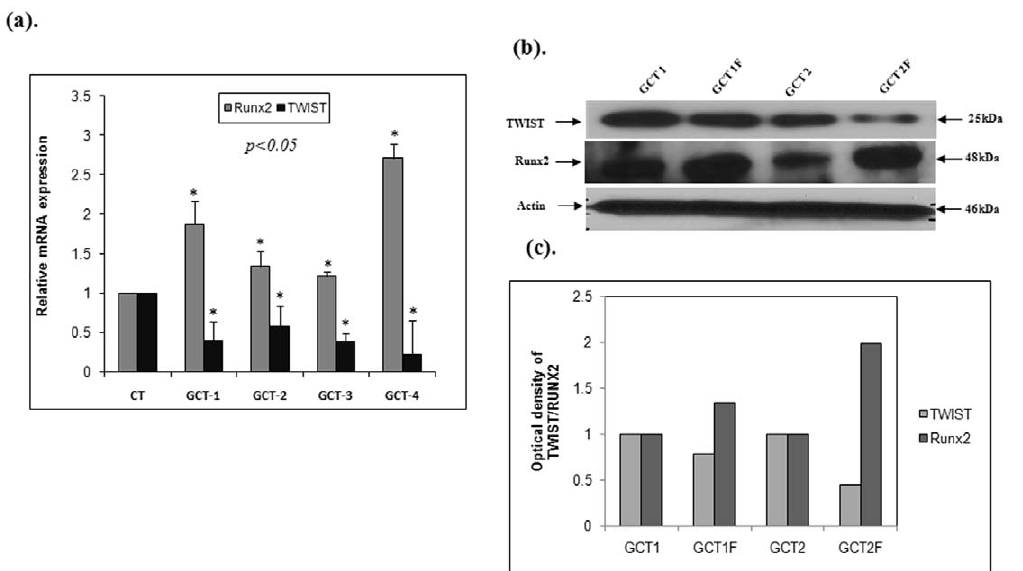
Figure 4. FGF-2 stimulation effects on osteoblastic transcription factors in GCT cells. Quantitative RT-PCR, Western blot and quantification analysis representing a significant decrease in TWIST1 and a significant increase in Runx2 mRNA and protein levels in GCT cells treated with FGF-2 (GCT1F, and GCT2F,) when compared to the GCT untreated (GCT1, and GCT2) FGF-2 cells.